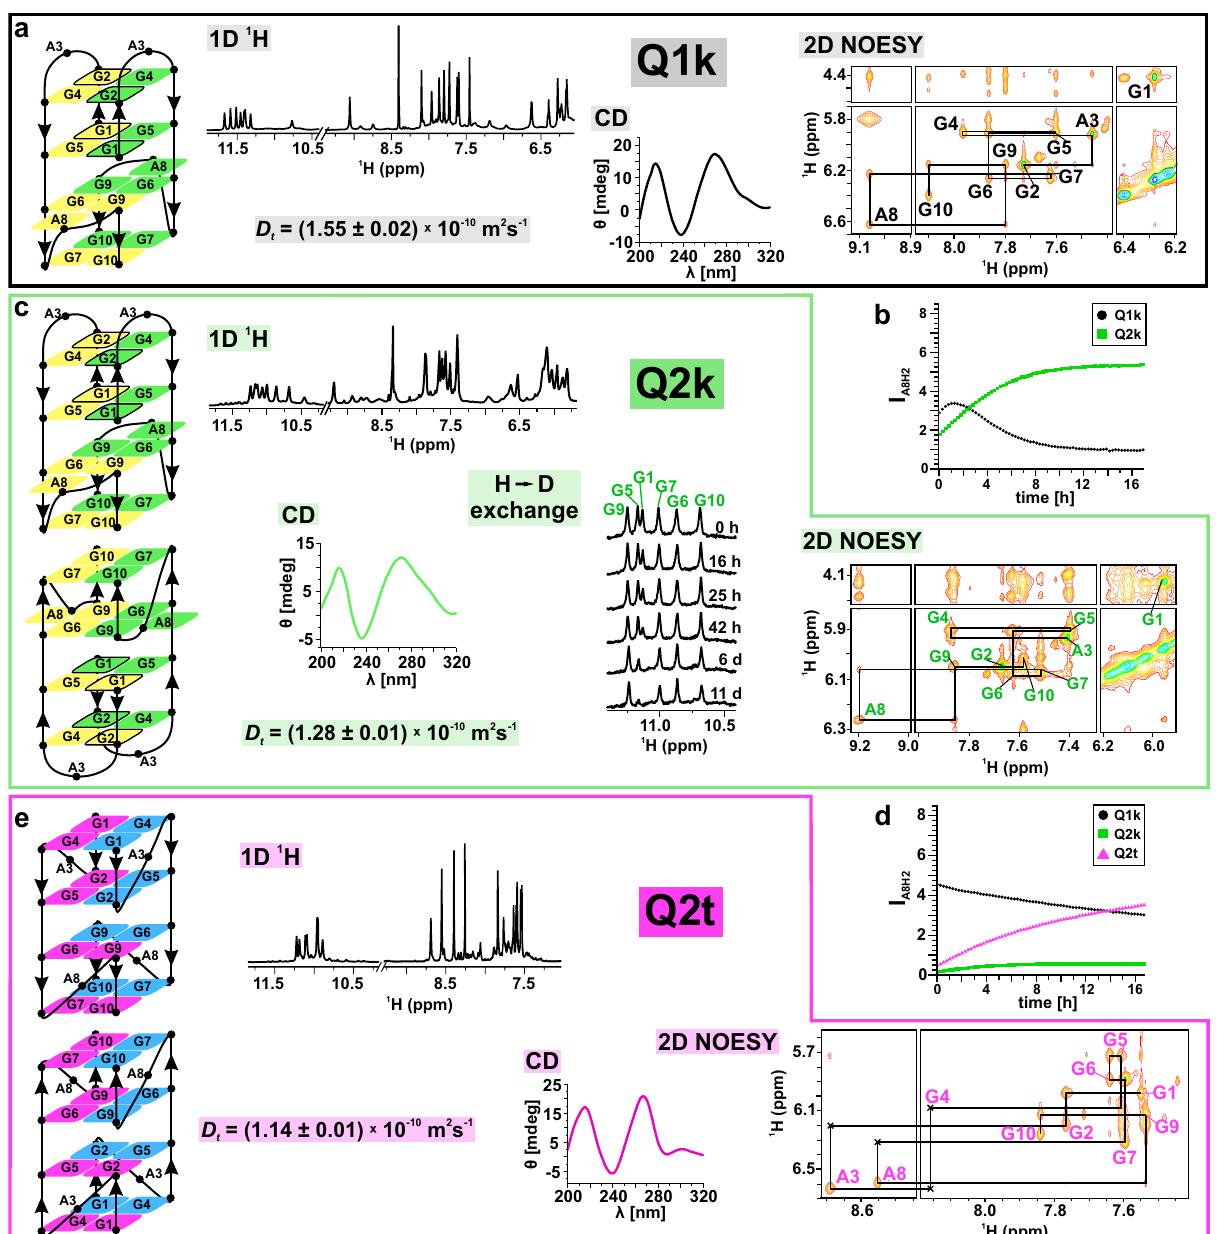
Fig. 2 Initial steps of d(G 2 AG 4 AG 2 ) G-wire self-assembly. a NMR data, CD spectrum and folding topology of Q1k. In 2D NOESY spectrum ( τ m 150 ms) the intra-nucleotide H8 (n) -H1 ′ (n) cross-peaks are labeled with corresponding residue numbers, where their observed intensities reveal syn conformation along glycosidic bond for G1 and G2 and anti for the remaining residues. Black lines show sequential walk, which is followed from G2 up to G10 residue via H8 (i) -H1 ′ (i) and H1 ′ (i) -H8 (i + 1) connectivities as characteristic for anti - anti step. G1 and G2 residues in syn conformation are presented with rectangles surrounded with black in Q1k folding topology. Arrows indicate progression of strand from 5 ′ → 3 ′ end. b Q1k → Q2k transformation at 0 °C in 100 mM KCl. c Folding topology of Q2k and corresponding NMR and CD data. Similarly to Q1k, sequential walk in Q2k is followed from G2 up to G10 residues in 2D NOESY spectrum ( τ m 150 ms). Deuterium exchange experiment supports 3 ′ -3 ′ stacking in Q2k. d Q1k → Q2k → Q2t transformation at 25 °C in 3 mM KCl. e Structural differences between Q2t and Q1k/Q2k are re fl ected in CD, 1D 1 H and 2D NOESY ( τ m 150 ms) spectra. Crosses in 2D NOESY denote weak cross- peaks. Simpli fi ed scheme of these structures is presented in Fig. 3. Samples were assembled via a method 3, b method 2, c method 4, d method 2, and e method 5 (see “ Methods ”